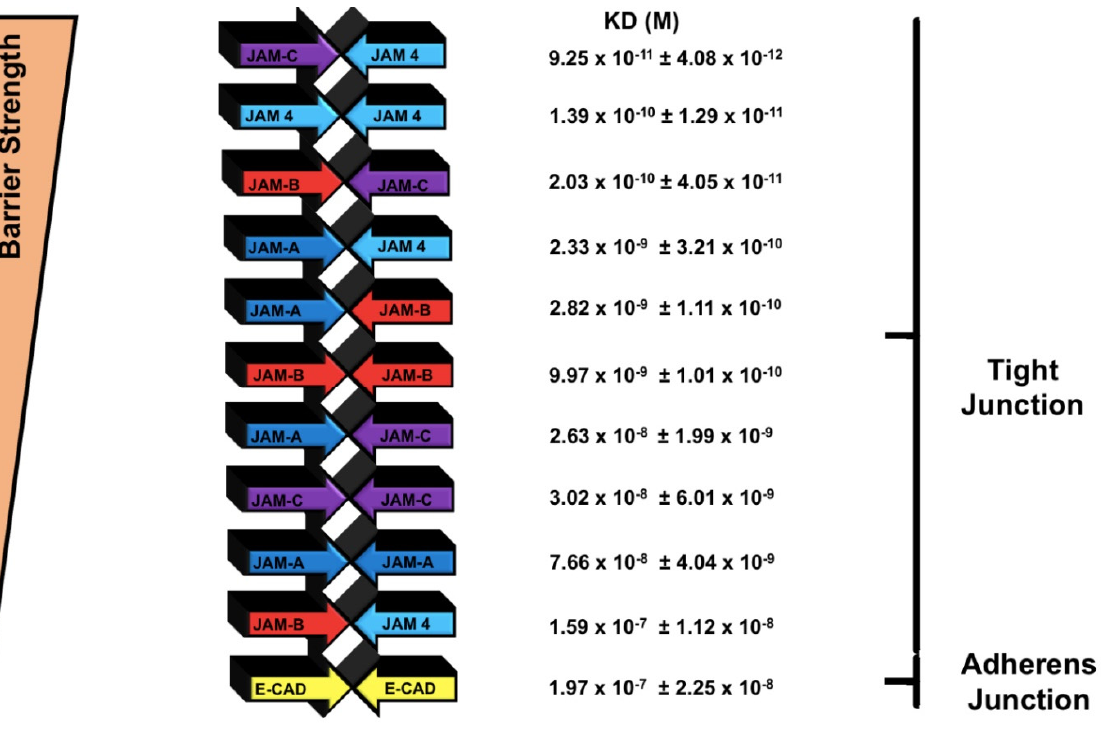
Figure 5. Ranked strength of homotypic and heterotypic interactions. In this figure, we summarize the major findings of our research. Graphically, we display the homo- and heterotypic interactions of JAMs, and the homotypic interactions of E-CAD. The ranking of these interactions is in order of strength.